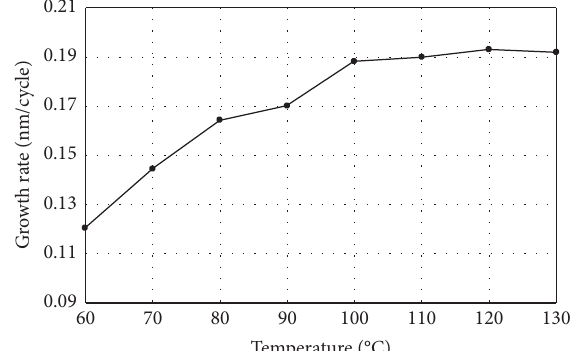
Figure 4: Growth rate of the ZnO layers on the UHMWPE surface was shown at diferent